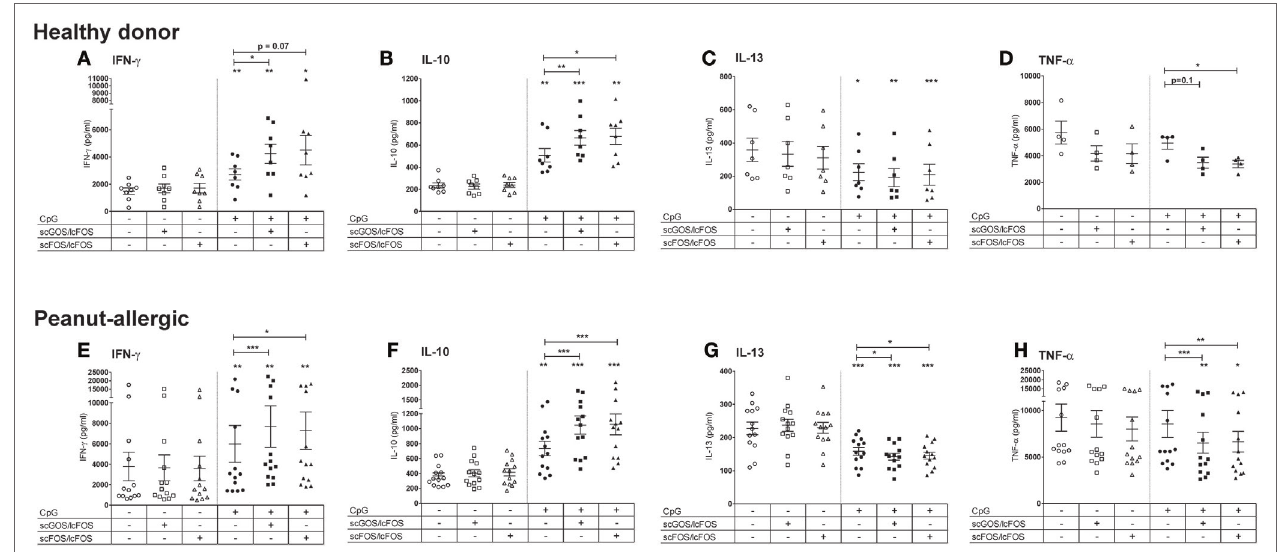
FigUre 2 | Comparison aspecific co-culture model between healthy donors and peanut-allergic donors. Apical exposure of intestinal epithelial cells (IECs) to non-digestible oligosaccharides in absence of CpG oligodeoxynucleotides (ODN) did not affect cytokine concentrations in the basolateral compartment (a–h) . CpG exposure increased IFN- γ and IL-10 production (a,B) in healthy donors, which was further increased by the combined exposure to CpG ODN and oligosaccharides. In addition, IL-13 was decreased by CpG exposure alone (c) and TNF- α production decreased in the combined presence of oligosaccharides